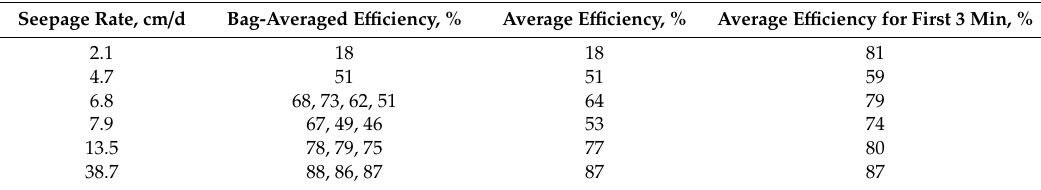
Table 1. Seepage rate, in cm / d, relative to bag e ffi ciency, in percent; averaged over each bag connection (second column) or averaged over all bag attachments that were considered in the acceptable mid-range of bag fullness (third column). For averages of first 3 min of bag attachment (fourth column), attachments with initial values > 100 percent were not